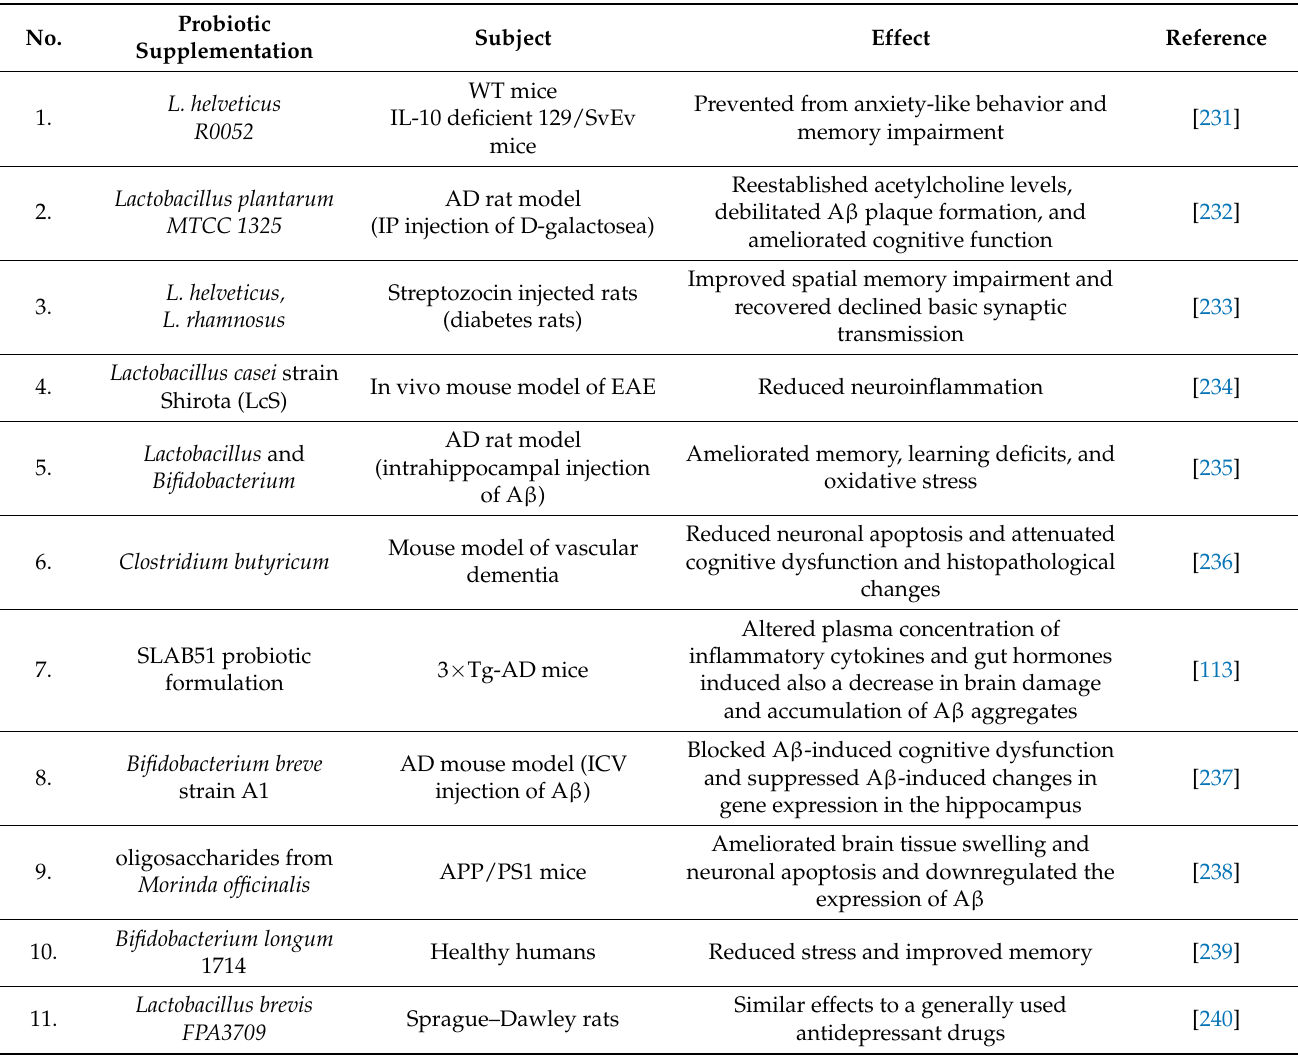
Table 4. Effects of probiotics on neurological